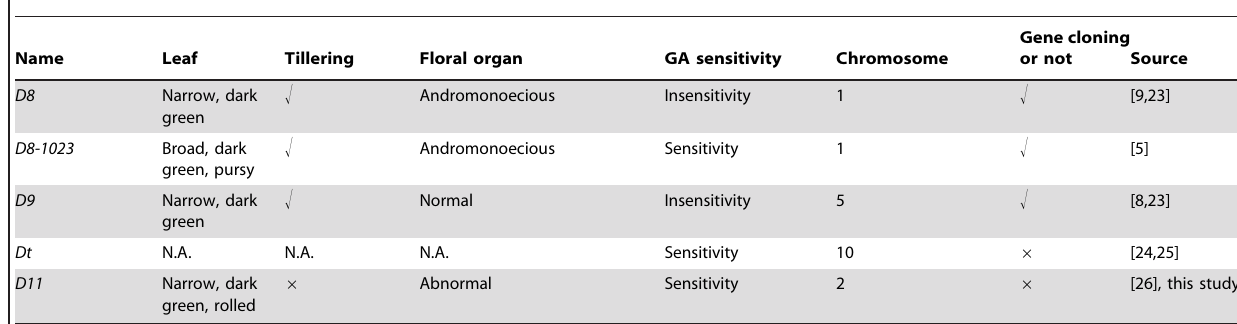
N.A. indicates not available. doi:10.1371/journal.pone.0066466.t001 PLOS ONE |